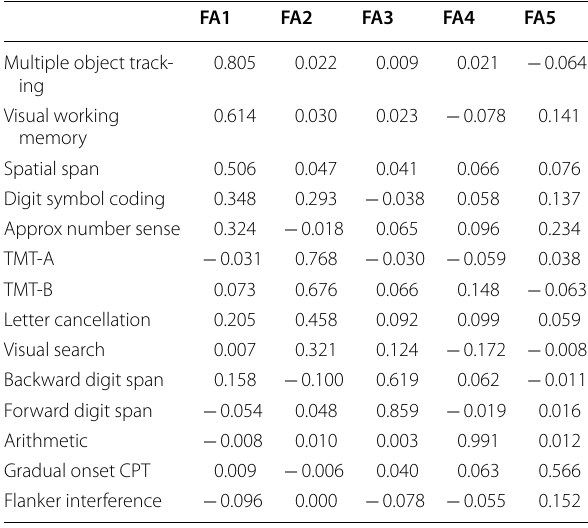
Table 7 Factor loadings for the five-factor